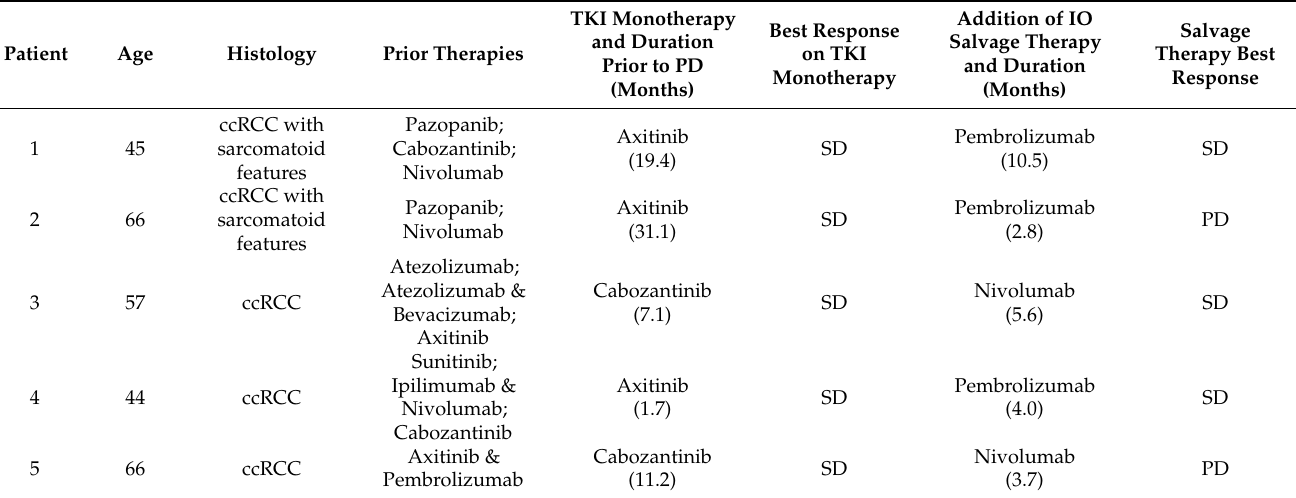
Table 1. Patient and treatment